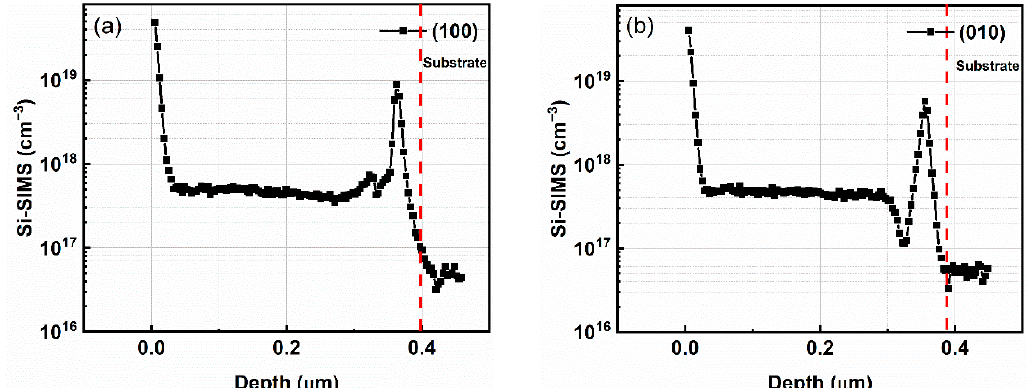
Figure 5. The Si profiles by SIMS of ( a ) (100) and ( b ) (010) in the same-chamber experimental run. The experimental conditions are: the growth rate is maintained at 0.9 µm/h with the TEOS molar flow kept at 1.84 × 10 − 10 mol/min. The red dashed line indicates the interface between the substrate and the grown film.